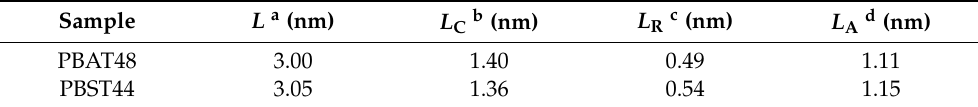
Table 6. Three-phase layer thickness of PBAT48 and PBST44 calculated from SAXS results.